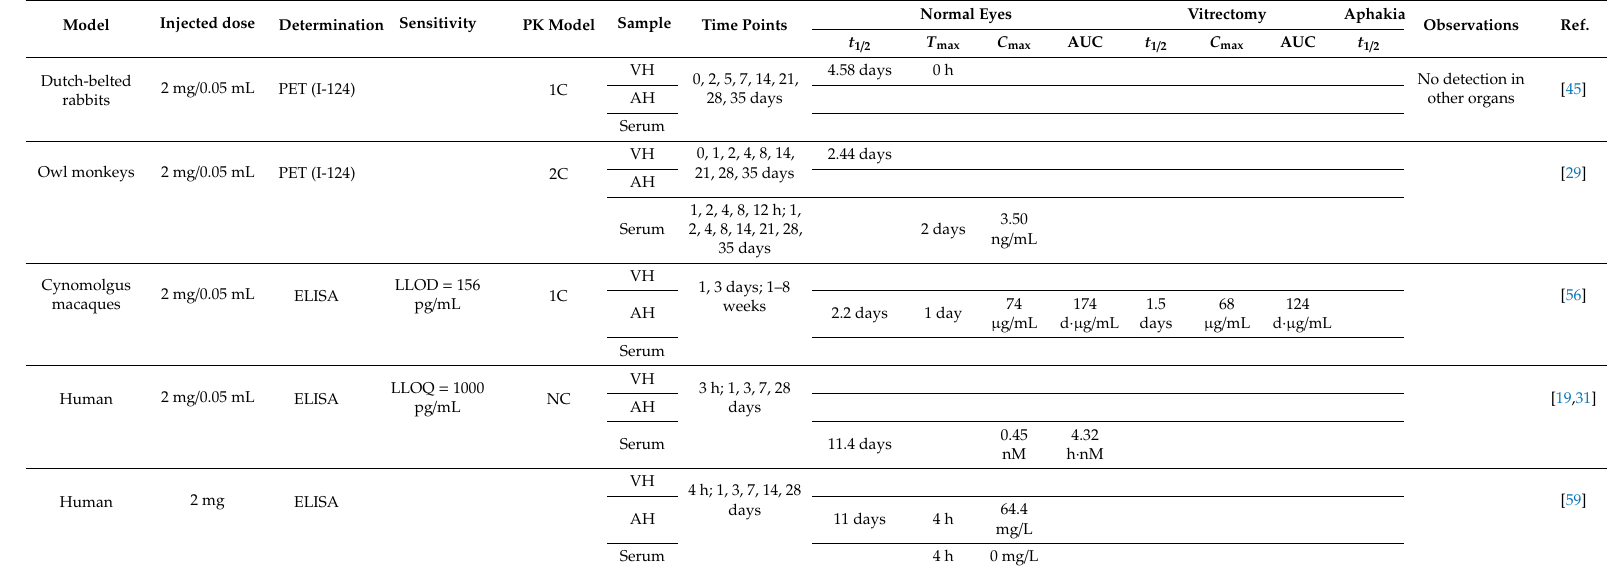
Table 4. Pharmacokinetic parameters of intravitreal aflibercept in di ff erent